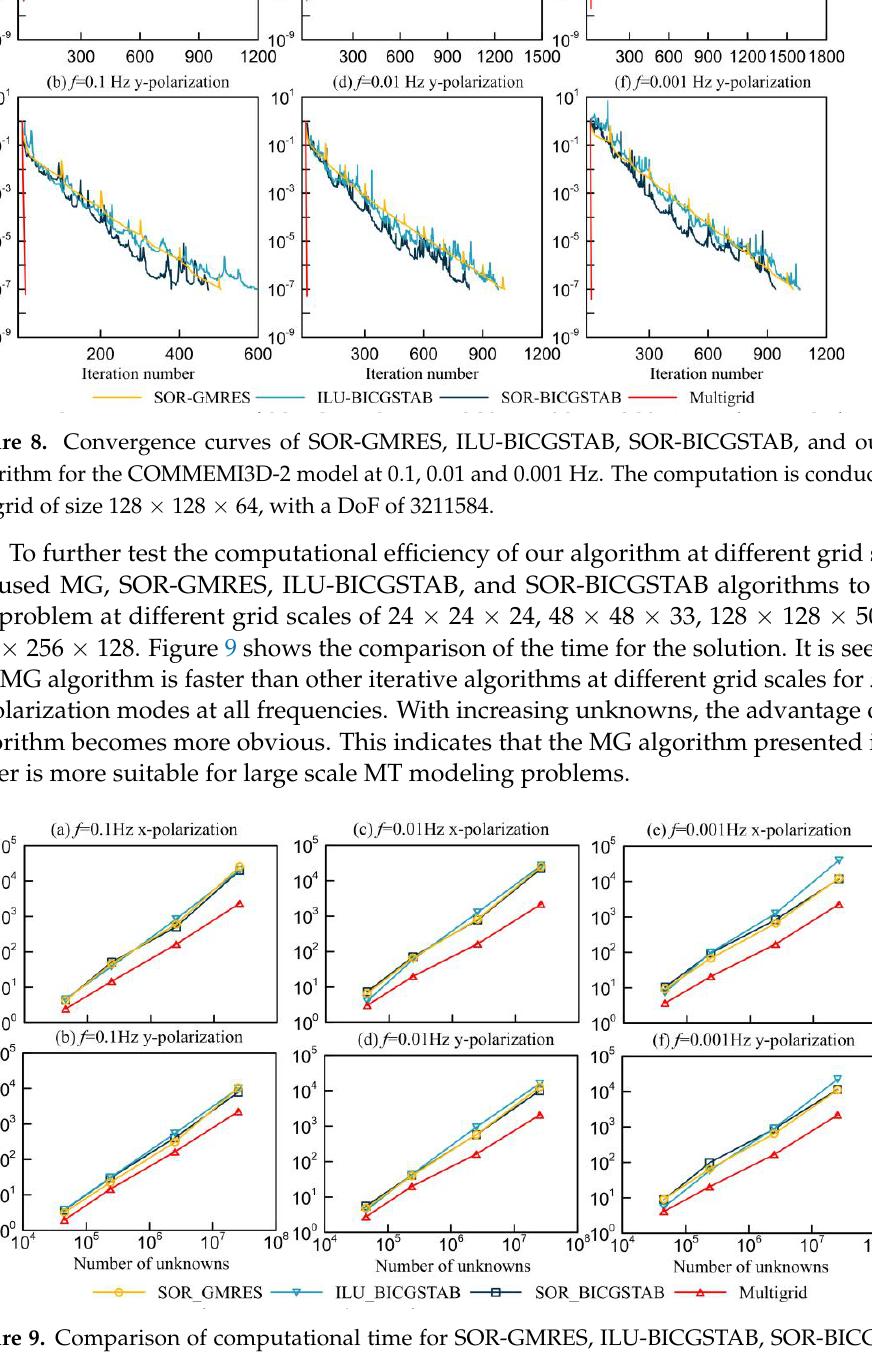
Table 1. Computational performance of SOR-GMRES, ILU-BICGSTAB, SOR-BICGSTAB, and MG algorithm for COMMEMI3D-2 model in x - and y -polarization modes at 0.1, 0.01 and 0.001 Hz.